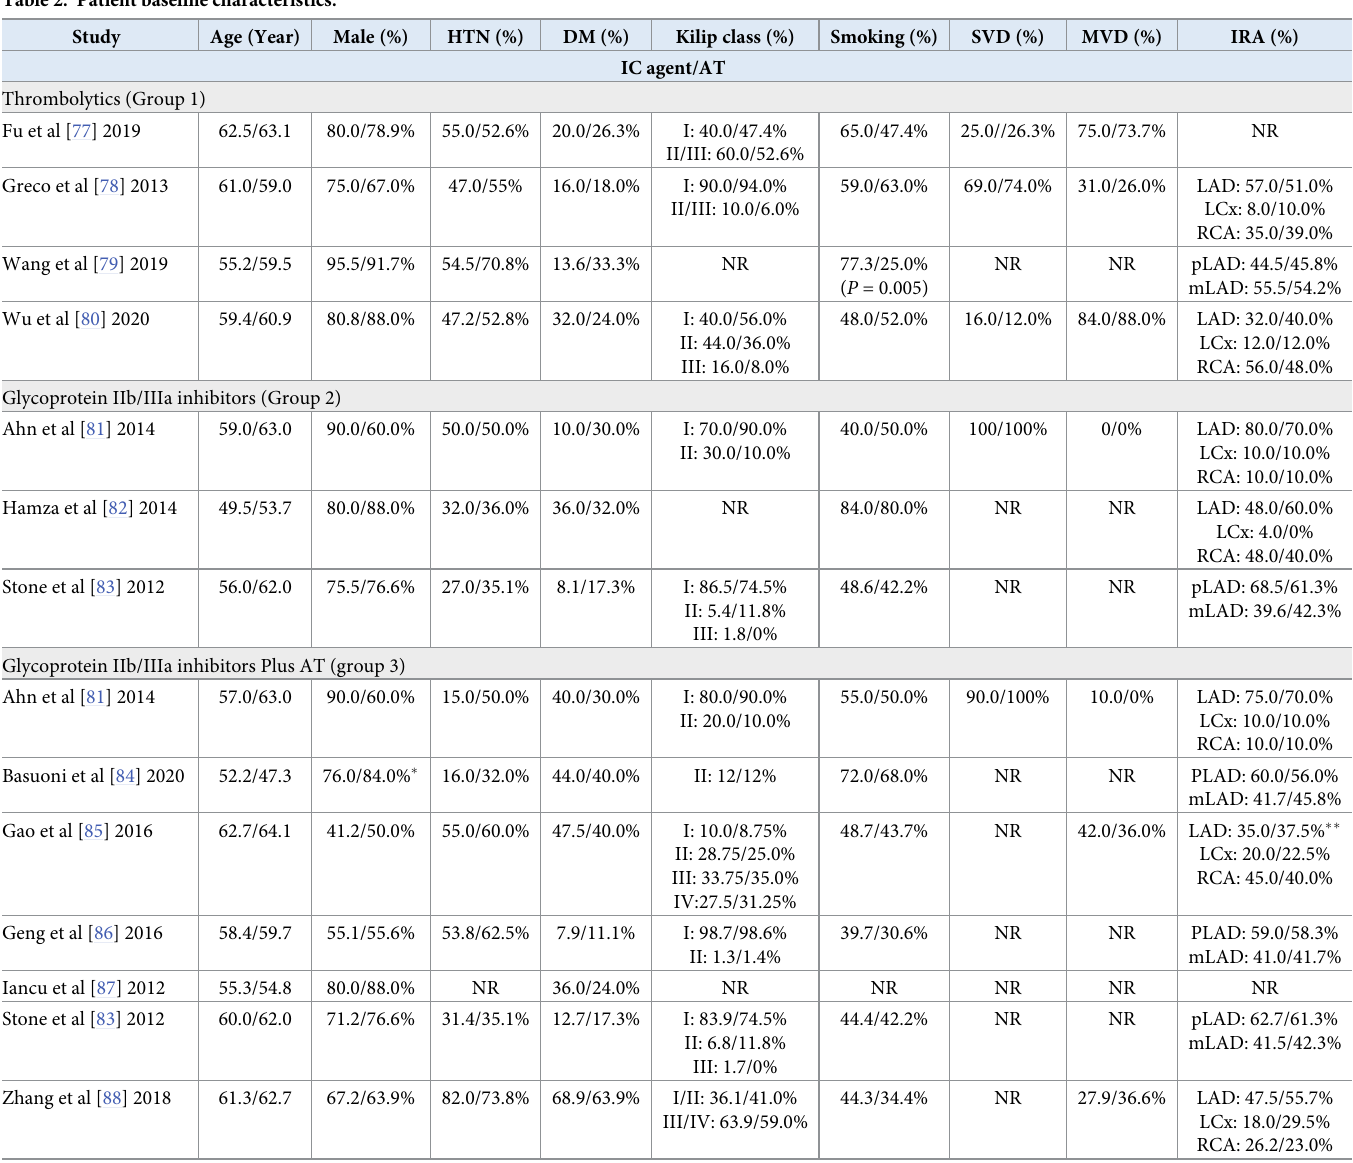
Table 2. Patient baseline